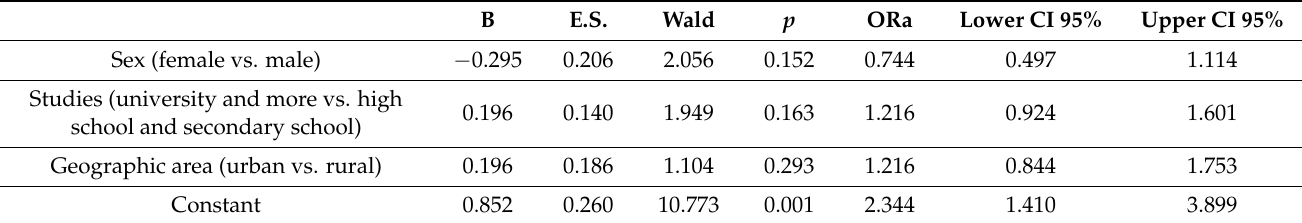
Table 2. Logistic regression model for COVID-19 vaccination. B E.S. Wald p ORa Lower CI